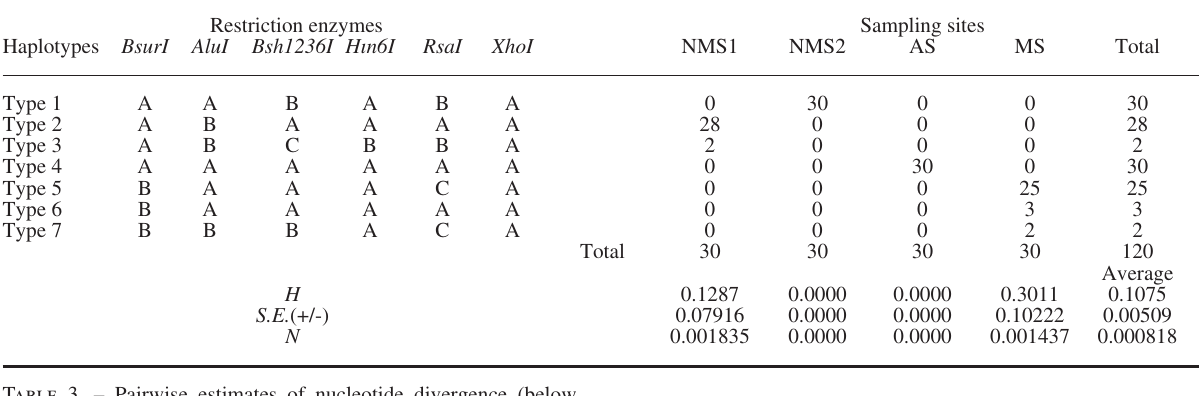
Table 3. – Pairwise estimates of nucleotide divergence (below diagonal) and F (above diagonal) values among S. officinalis ST populations. ***, significance value ( P <0.001).